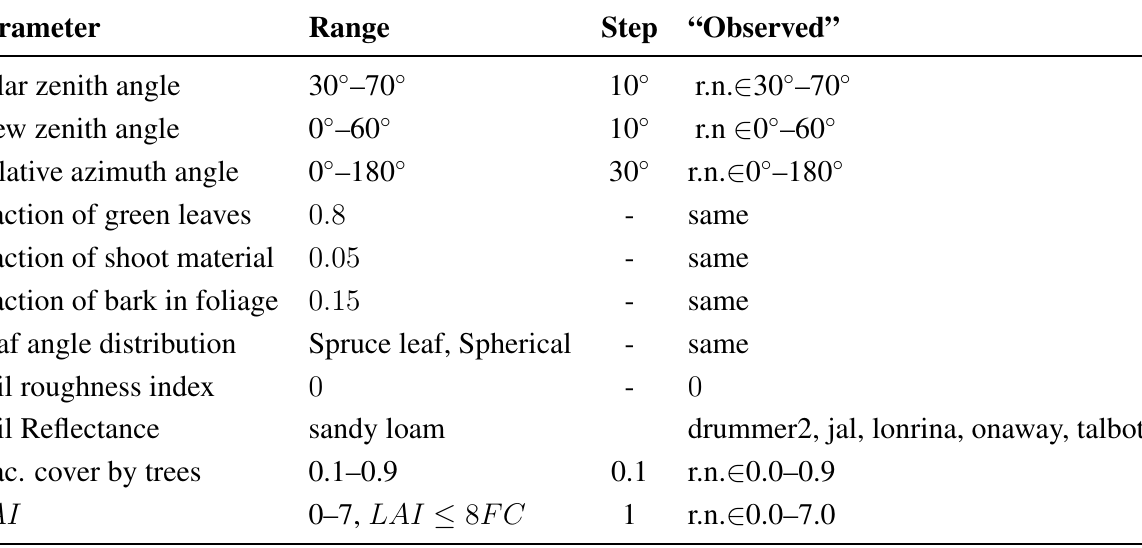
Table 2. FLIGHT input parameters. The column “range” represents the minimum and maximum values of the input parameters; column “step” is the increment for the LUT; column “Observed” represents the range over which a random number “r.n.” is selected to , ..., λ ) . Thus the simulations and LUT are generated generate satellite observed BRF, R ∗ ( λ 1 n from different input parameters; in particular, different values are used for viewing geometry, soil reflectance, fractional cover, and leaf area index (Section 6.4).